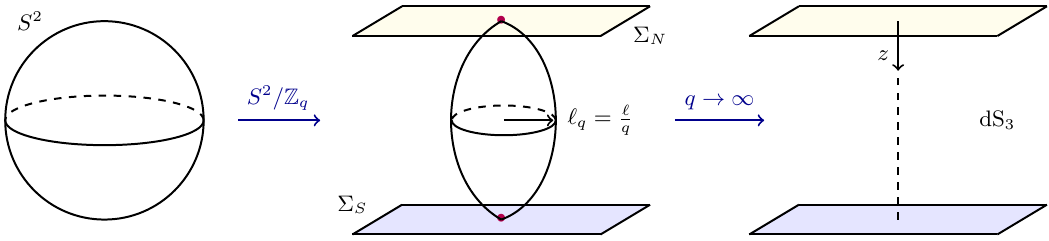
Figure 3 . The q → ∞ limit of the geometry corresponds to the zero radius ‘ q limit where the spindle shrinks to a single traverse dimension between the defects. The resulting geometry corresponds to global dS 3